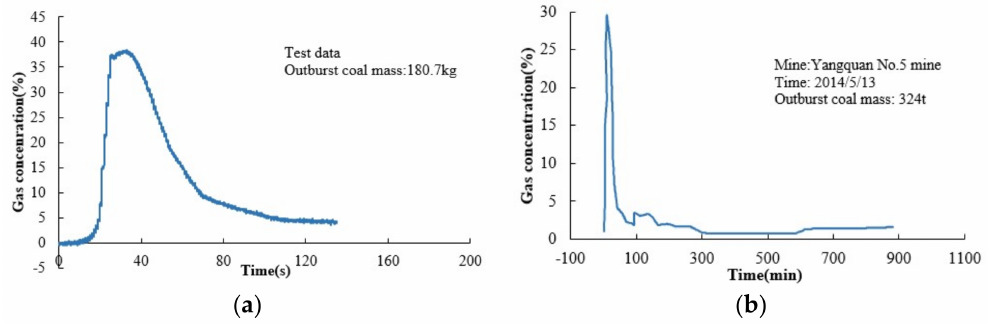
Figure 7. The CO 2 concentration curve of in the main roadway. ( a ) Test data; ( b ) Field data (Zhao W. et al., 2016).